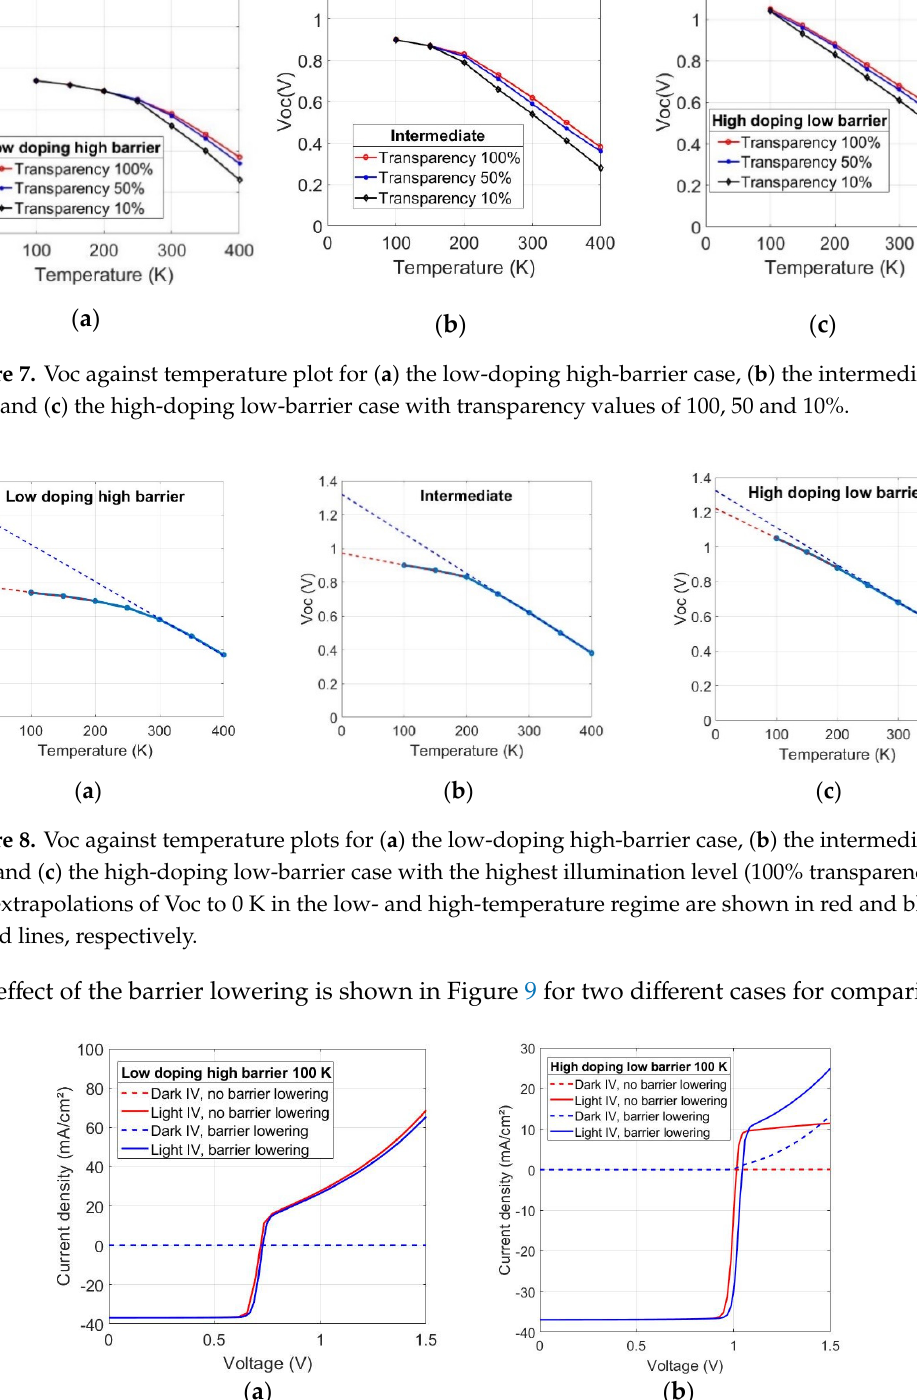
Figure 7. Voc against temperature plot for ( a ) the low-doping high-barrier case, ( b ) the intermediate